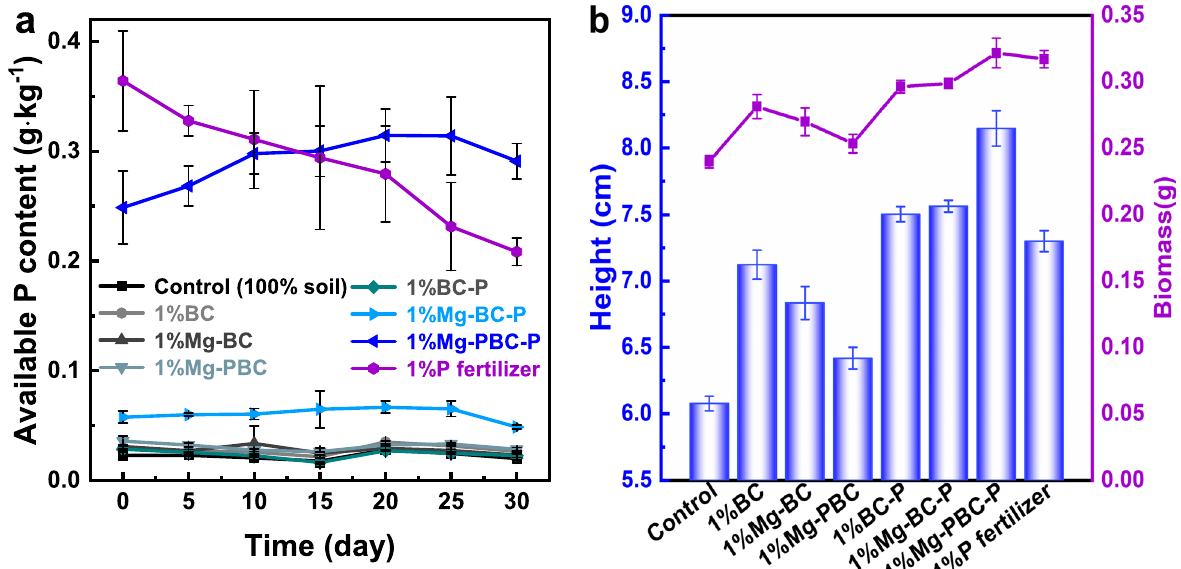
Fig. 8 Changes of available P content ( a ) and plant growth ( b ) in the soil treated with the studied biochar before (BC, Mg-BC, Mg-PBC) and after (BC-P, Mg-BC-P, Mg-PBC-P) P adsorption and a commercial P fertilizer